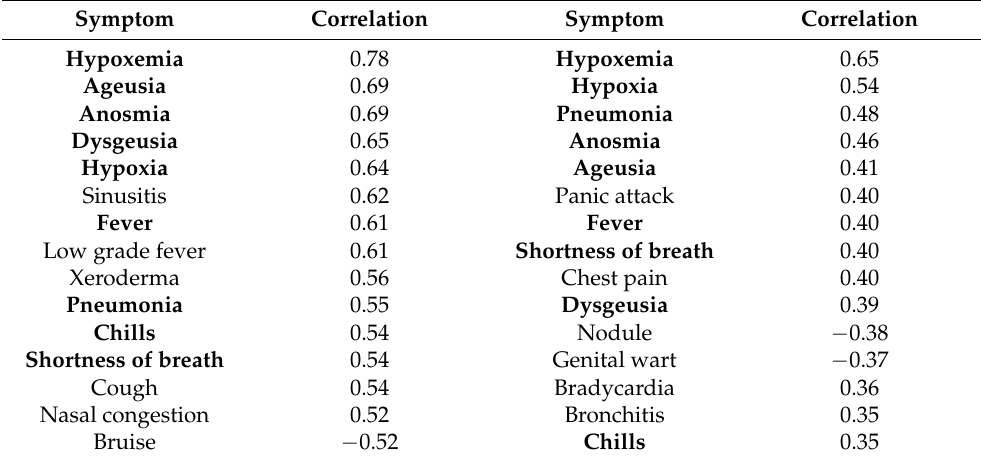
Table 3. Top 15 symptoms associated with COVID-19 confirmed cases and deaths, respectively. The nine symptoms shared in the two sets are highlighted in bold.